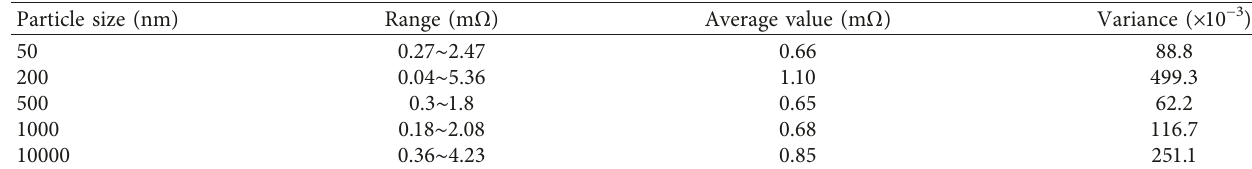
Figure 5: The contact resistance of Ag-SnO 2 /Fe 2 O 3 contact material with 50 nm doped particle size. Table 4: The contact resistance of Ag-SnO 2 /La 2 O 3 contact material.